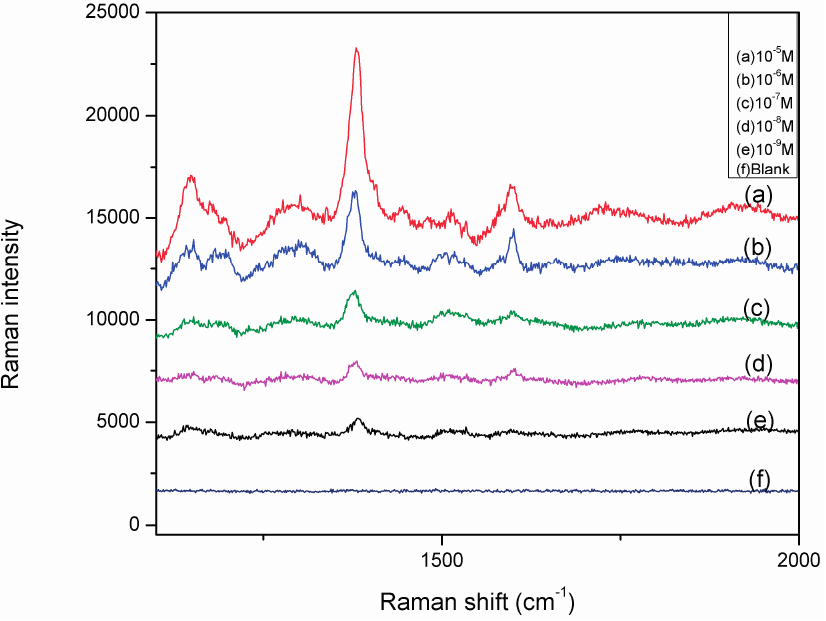
Figure 8. SERS spectra of thiram in acetone of various concentrations on Ag NPs@AuFON hybrid